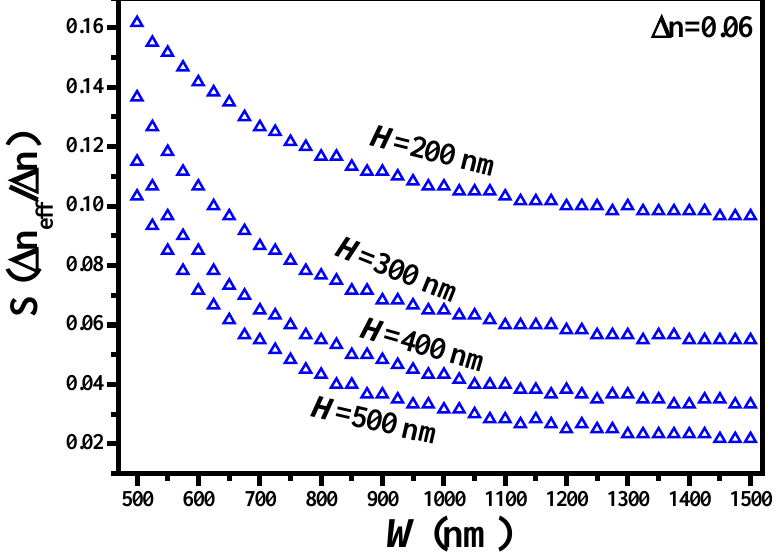
Figure 9. Mode sensitivity analysis of a ridge WG.